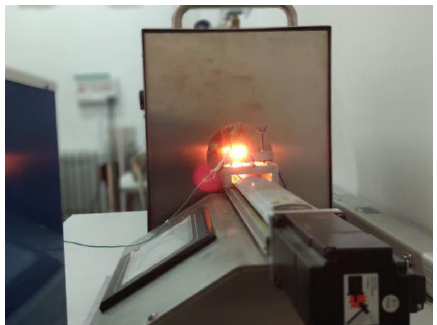
Figure 10. Thin-film thermocouple high-temperature section static test experiment site.